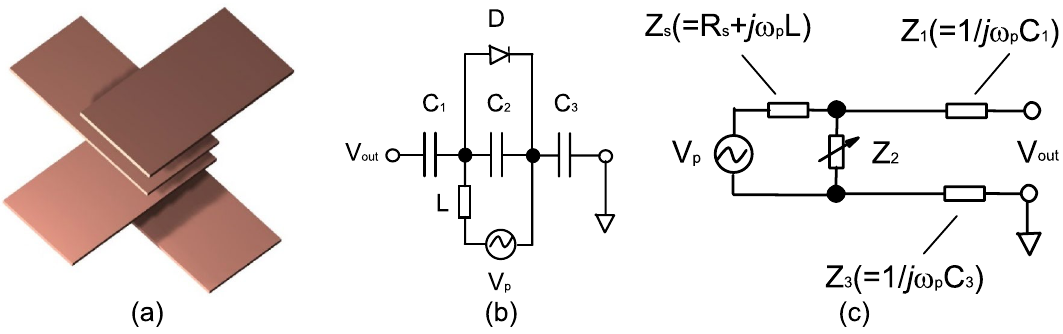
c Thevenin equivalent: Z is the capacitor impedance in paral- 2 lel with the varying diode resistance, and Z is the sum of the s source and inductor